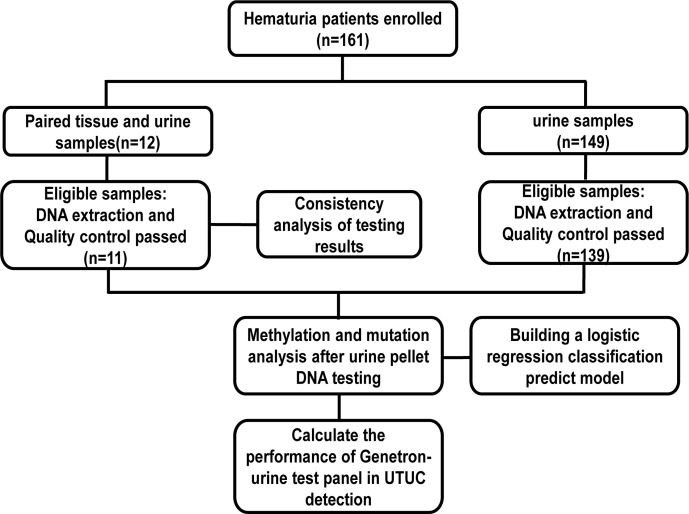
Sample and data processing work-flow.